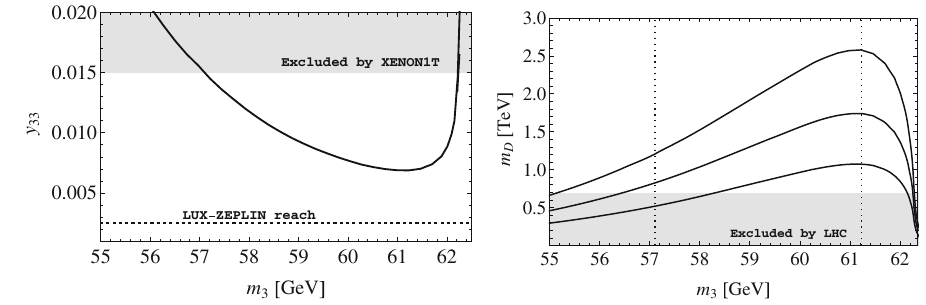
Fig. 4 Leftpanel: y 33 asafunction of m 3 (solidcurve)alongwhichthe observedDMdensityisreproduced.Thegrayshadedregionisexcluded by the XENON1T results and the horizontal dashed line marks the search reach of the future LUX-ZEPLIN experiment. Right panel: m D